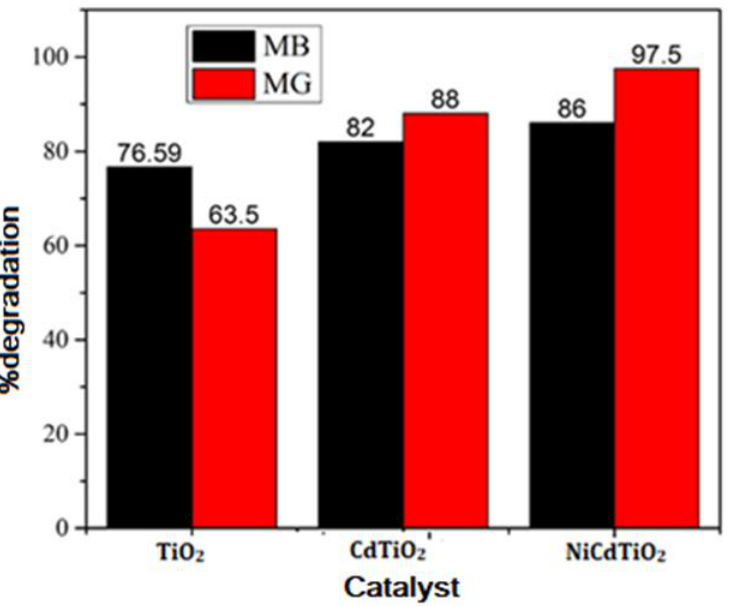
Figure 16. Comparison of %degradation of MB and MG dyes photodegraded by all the photocata- lysts.